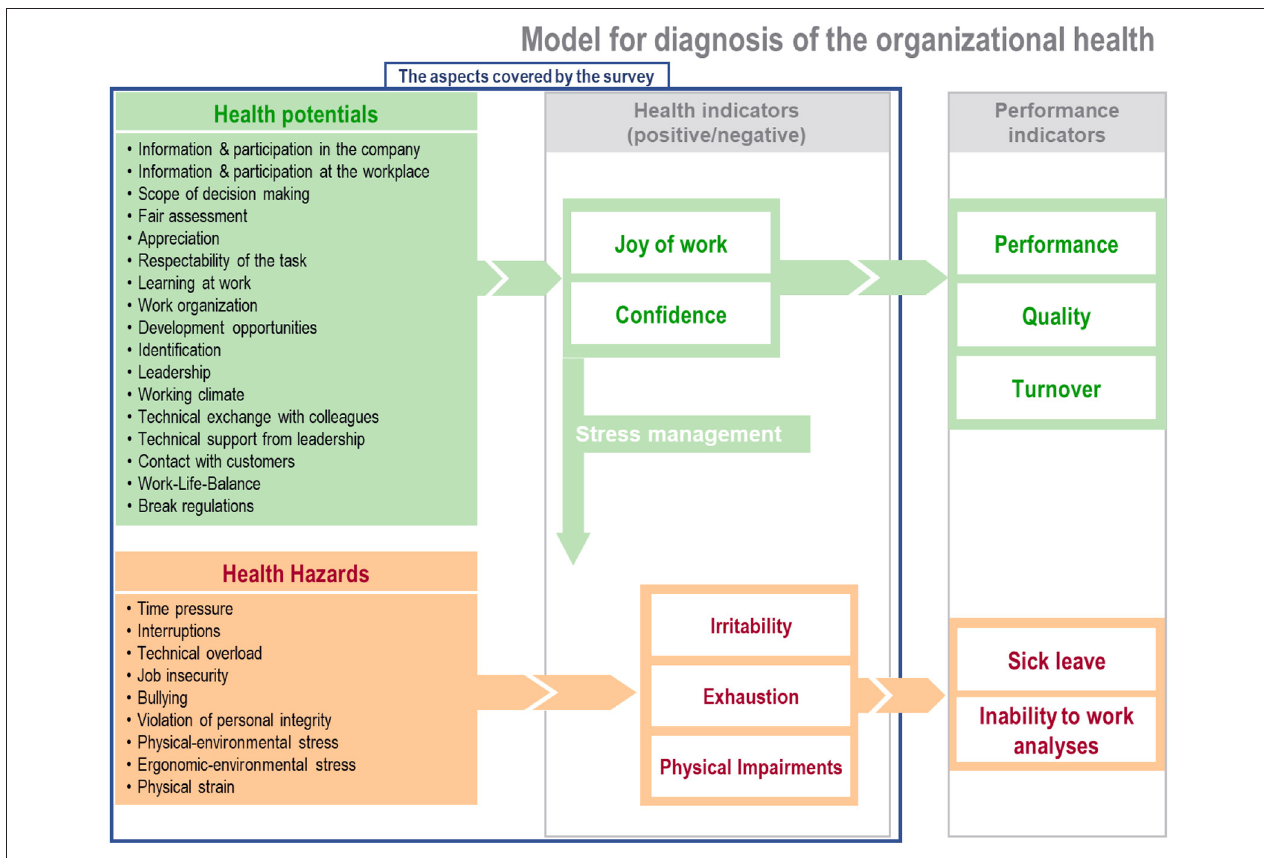
FIGURE 1 | Model for the diagnosis of corporate design ( © BGF